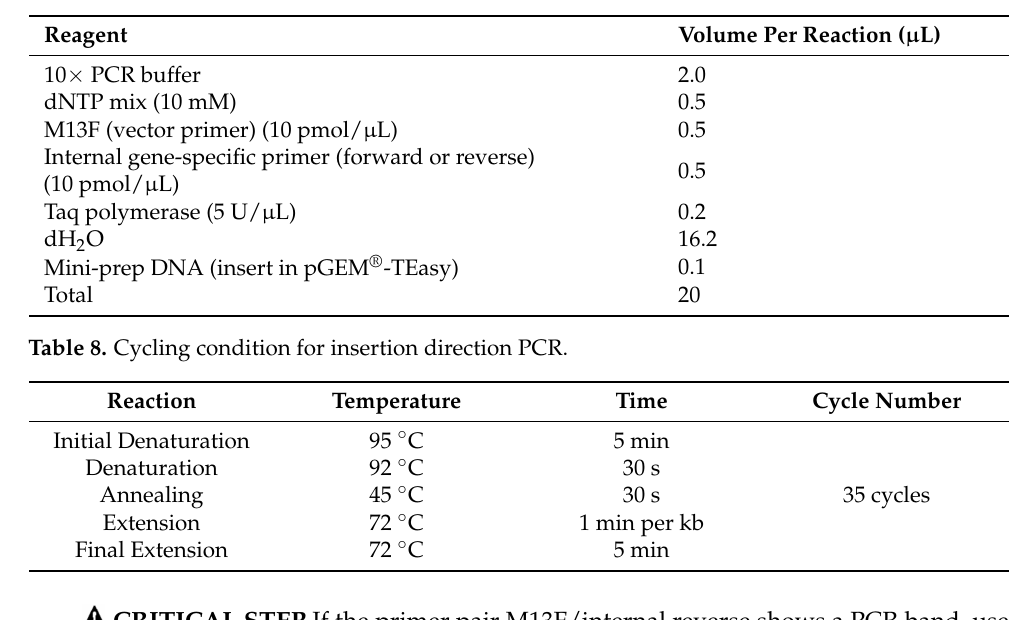
Table 7. Reaction mix for insertion direction PCR.